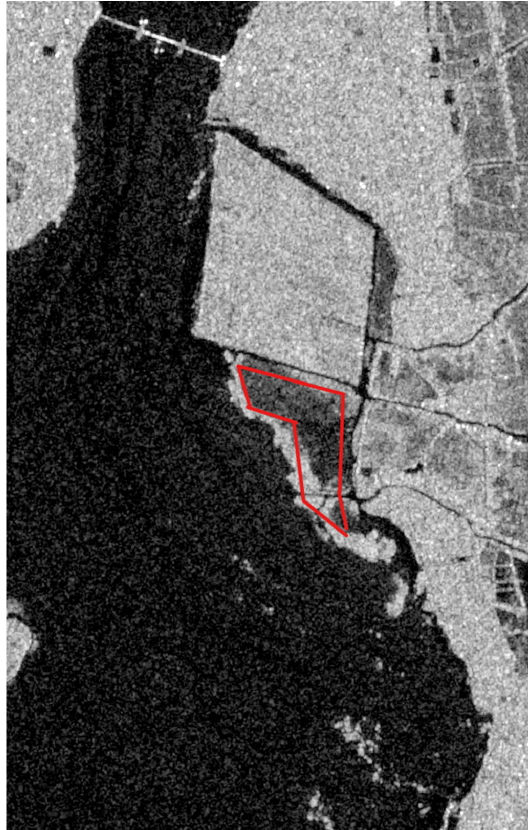
Figure 14. Mask of infested region, south of barrage, within Vembanad Lake, 19 October 2019. The red polygon highlights the region used for the infected mask. (Sentinel-1, Credits: ESA). This infested mask was tested against the same April clean date (Figure 9). From this new infested mask, ROC curves were created to assess the accuracy of the detectors on the lower-density water hyacinth (Figures 15 and 16).